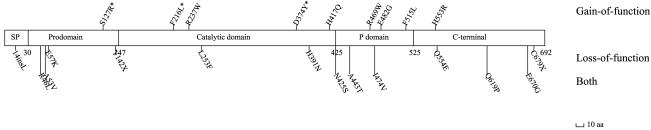
Distribution of non-synonymous variations along PCSK9.There are five functional domains in the PCSK9 protein [4]–[6]: 1) a signal peptide (SP) (1∼30 aa), 2) a prodomain (31∼147 aa), 3) a catalytic domain (148∼425 aa), 4) a putative P domain (426∼525 aa), and 5) a C-terminal domain (526∼691 aa). Gain-of-function mutations are only identified in families with hypercholesterolemia [10] or subjects with high LDL cholesterol levels [17], and loss-of-function mutations in subjects with low levels of LDL cholesterol [15]–[19]. Some non-synonymous mutations have been identified in subjects with either high or low plasma LDL cholesterol [4], [17], and are labeled ‘both’ in the figure. Rare mutations found in families with autosomal dominant hypercholesterolemia are labeled with an asterisk. The gain-of-function mutations are: S127R, F216L, R237W, D374Y, H417Q, R469W, E482G, F515L and H553R. The loss-of-function mutations are: 14insL, E57K, Y142X, L253F, H391N, Q554E, and C679X. Mutations associated with either high- or low- plasma levels of LDL cholesterol subjects are: R46L, A53V, N425S, A443T, I474V, Q619P, and E670G.